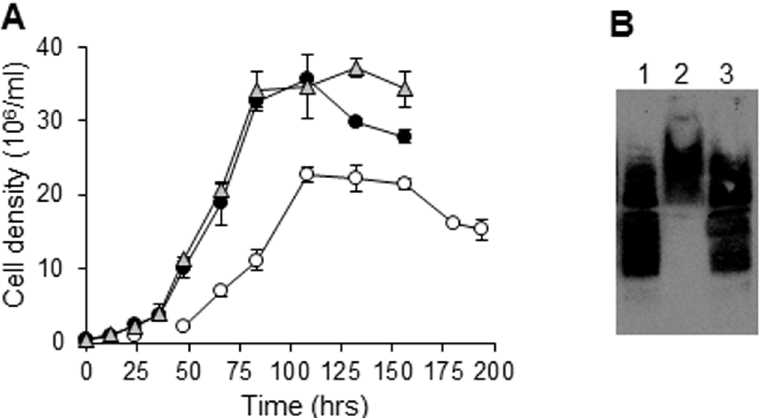
Fig 2. TbDAT complements the slow growth phenotype and restoressurvival during the stationary phase of growth of the L . major null mutant Δ lmdat/ Δ lmdat . (A) Growth curves were carried out as describedin Methods’section. White circles, null mutant Δ lmdat/ Δ lmdat [25]; black circles, complementedline Δ lmdat/ Δ lmdat [LmDAT NEO] ; grey circles, Δ lmdat/ Δ lmdat [TbDAT NEO] . This assay was performed twice in duplicateand standard deviations are shown. ( B ) Western blot analysisin the presence of lipophosphoglycan specific antibody WIC79.3 [35]. Equivalentof 2x10 6 cells was loadedin each lane. 1, complementedline Δ lmdat/ Δ lmdat [LmDAT NEO] ; 2, Δ lmdat/ Δ lmdat ; 3, Δ lmdat/ Δ lmdat [TbDAT NEO] .